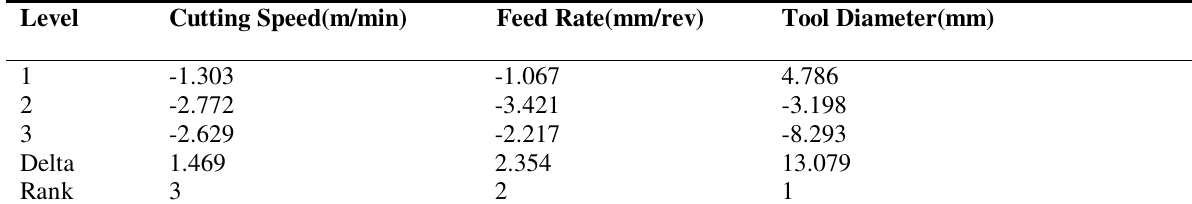
Table 7, Response Table for Signal to Noise Ratios .